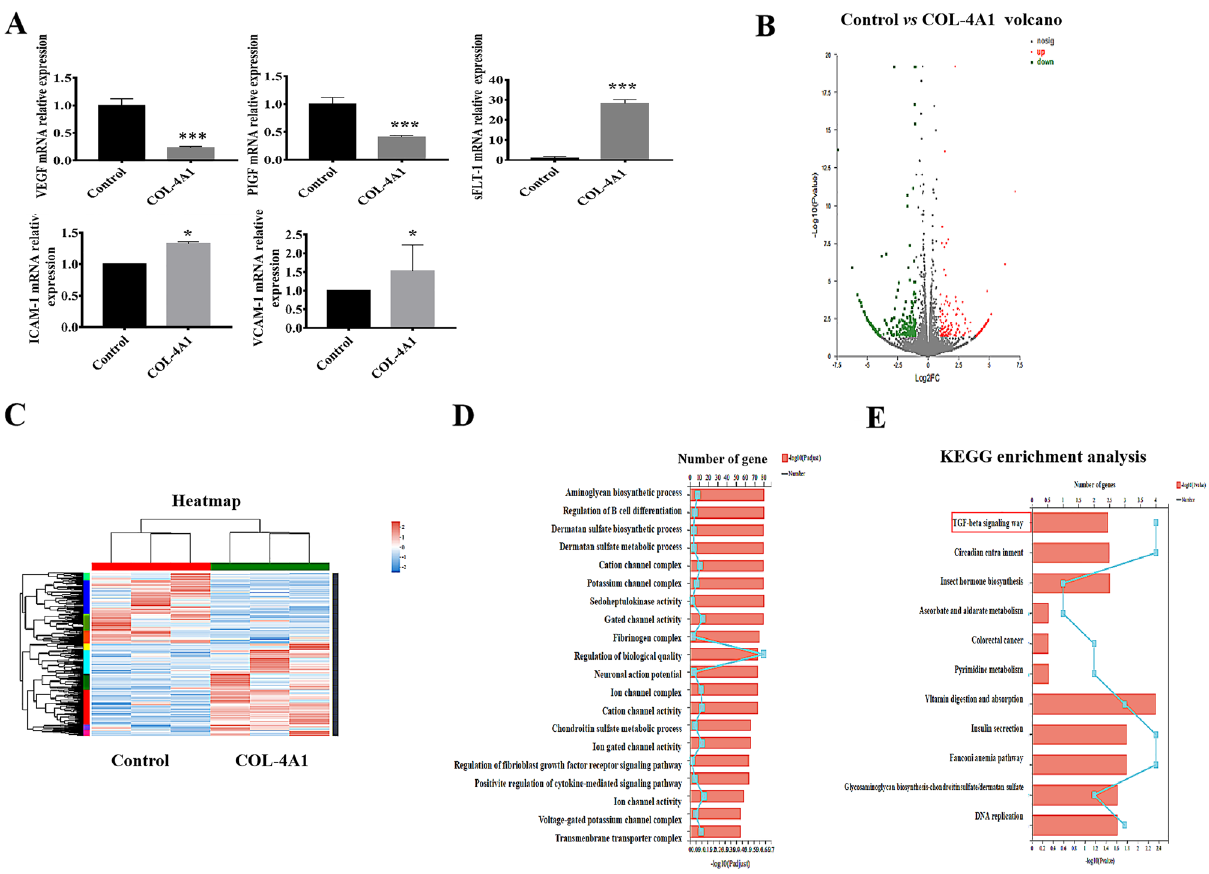
Figure 4. qRT-PCR assay and RNA sequencing of control vs COL-4A1-treated HUVECs. ( A ) Relative PIGF, VEGF, sFLT-1, ICAM-1 and VCAM-1 mRNA expression levels in each group. ( B ) Volcano plot. ( C ) Heat map. ( D ) Results of GO analysis. ( E ) Results of KEGG enrichment analysis. PIGF placenta growth factor, VEGF vascular endothelial growth factor, sFLT-1 soluble fms-like tyrosine kinase-1, ICAM-1 intercellular cell adhesion molecule-1, VCAM-1 vascular cell adhesion molecule-1, GO Gene Otology, KEGG Kyoto Encyclopaedia of Genes and Genomes. (* P < 0.05, ** P < 0.01, *** P <